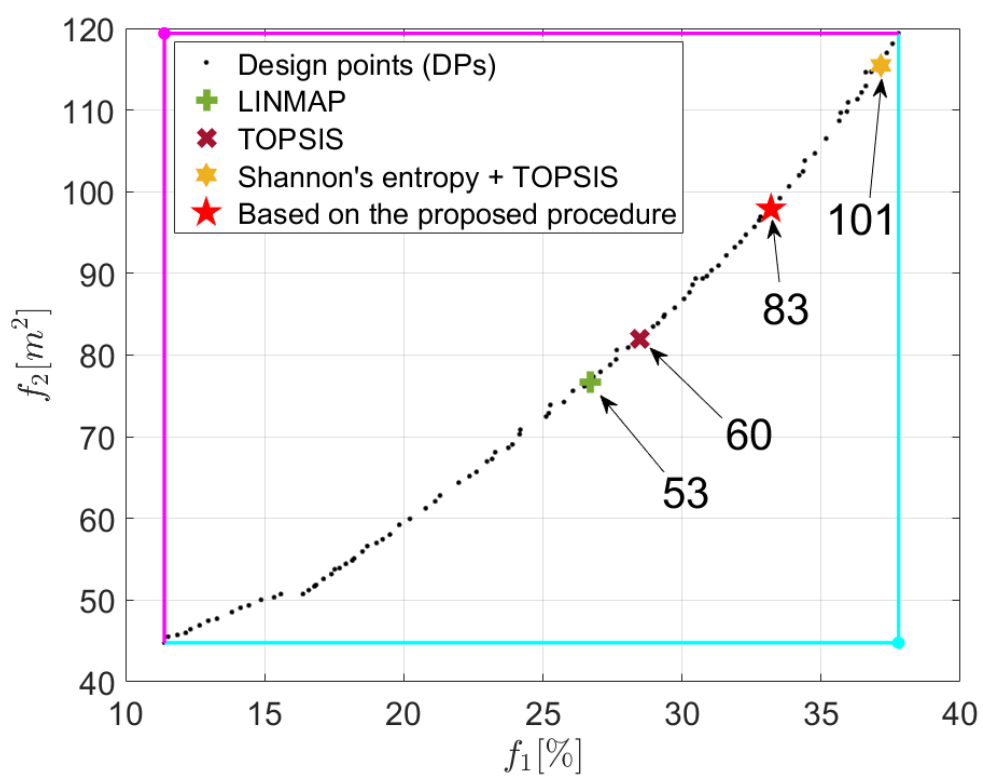
ff erent decision-making